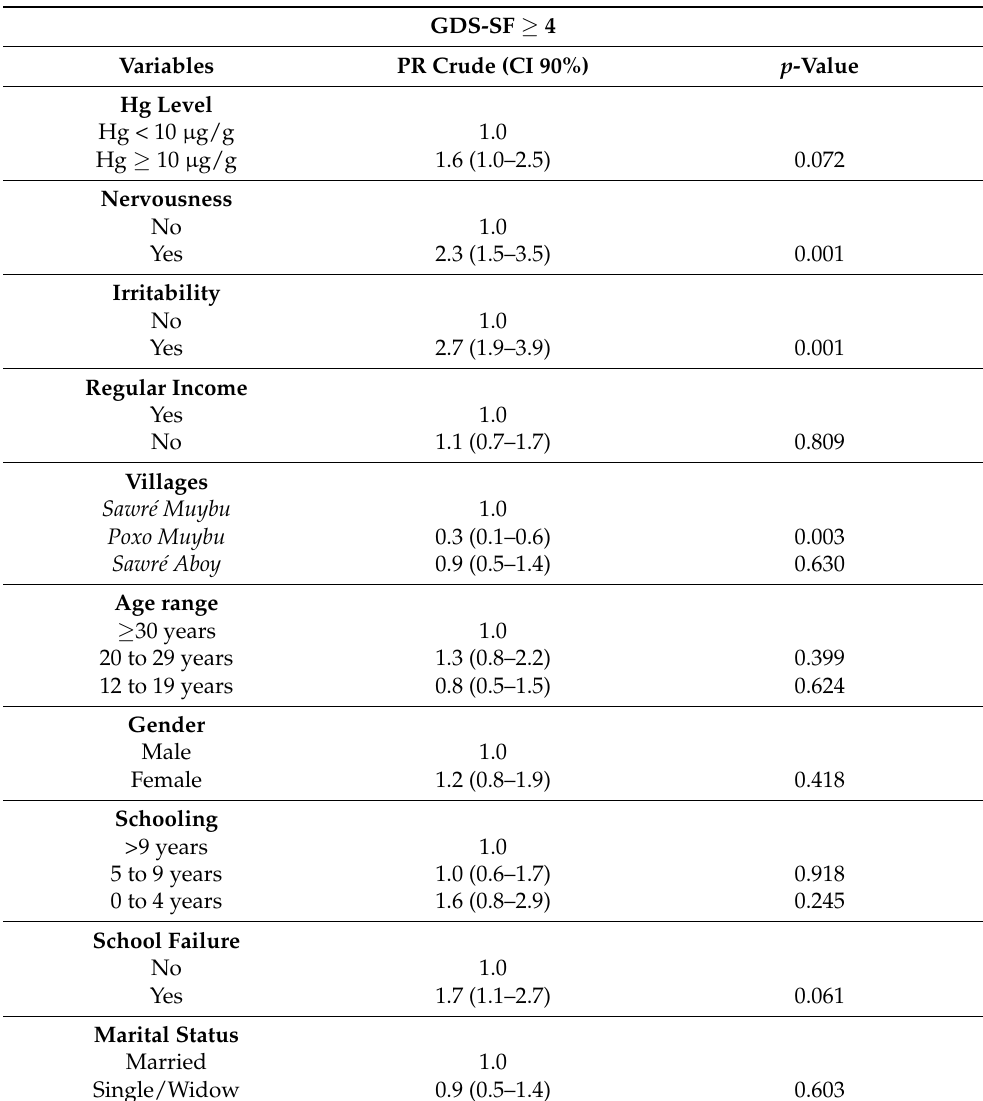
Table 2. Clinical and sociodemographic variables, according to GDS-SF scores ≥ 4 (Crude Poisson Regression Model). Sawr é Muybu Indigenous Land, Par á , Amazon, Brazil, 2019. GDS-SF ≥ 4 p